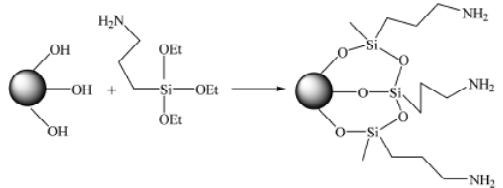
Figure 1. Illustration of the chemistry involved in the synthesis of APS-NZVI